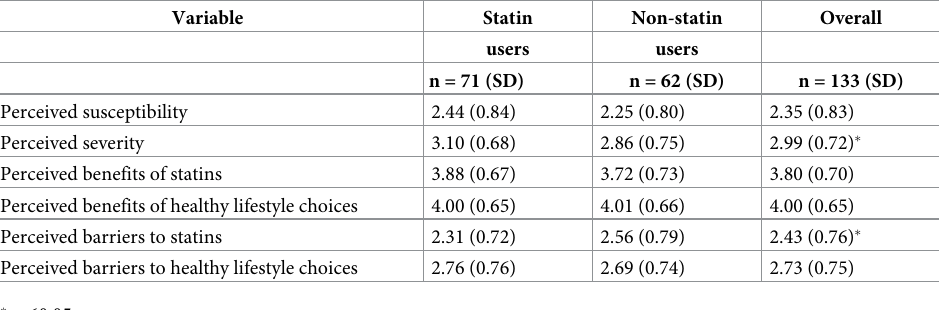
Table 5. Perceptions of future risk of cardiovascular disease.